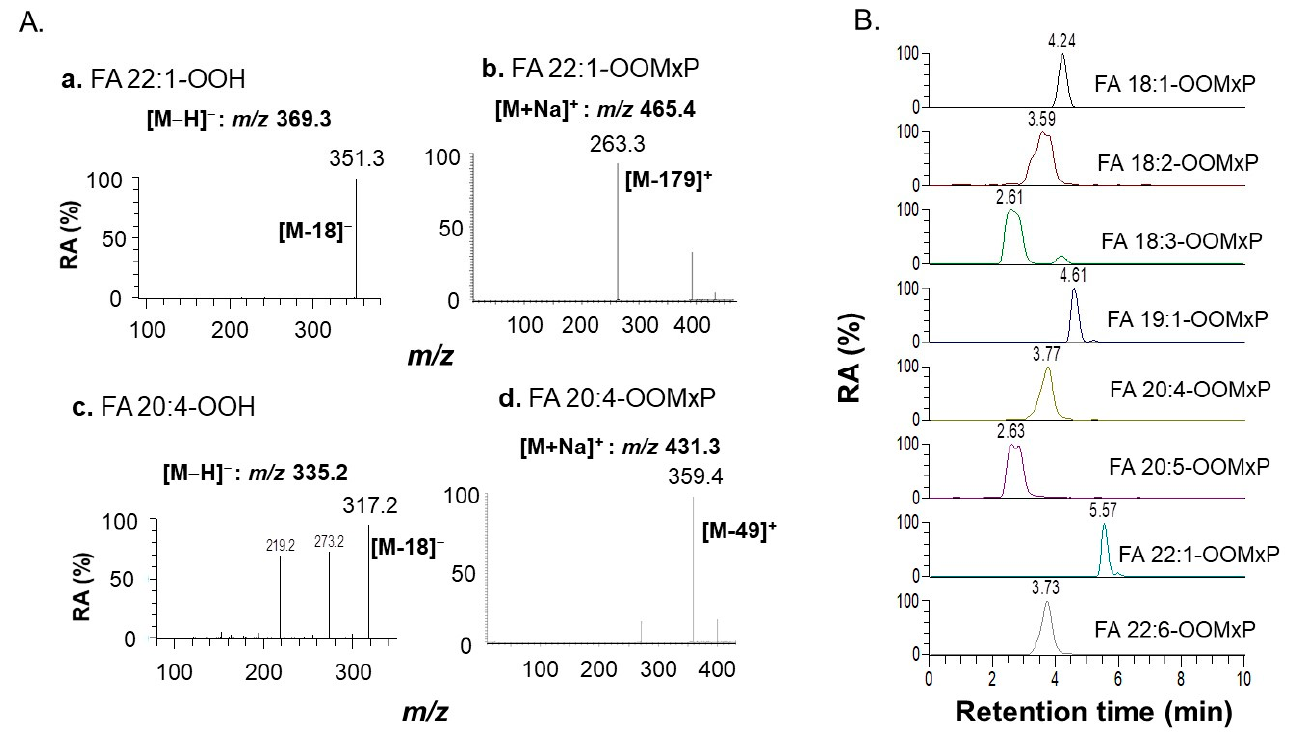
Figure 3. The MS/MS behavior of representative species and elution profile of 2-MxP derivatives. ( A ) The MS/MS spectra of mono-unsaturated (FA 22:1) and poly-unsaturated (FA 20:4) fatty acid hydroperoxides ( a , c ) and their 2-MxP derivatives ( b , d ). ( B ) Extracted ion chromatograms of FAOOMxP standards (in plasma matrix).